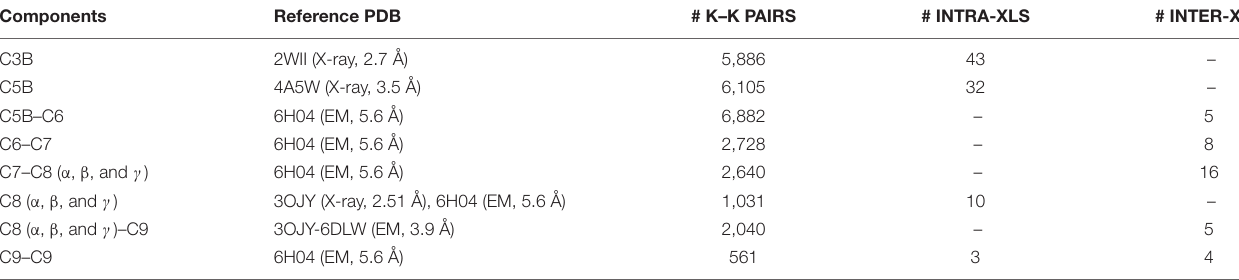
TABLE 1 | The Identified XLs for individual components of pairwise protein–protein interactions with previously solved structures.